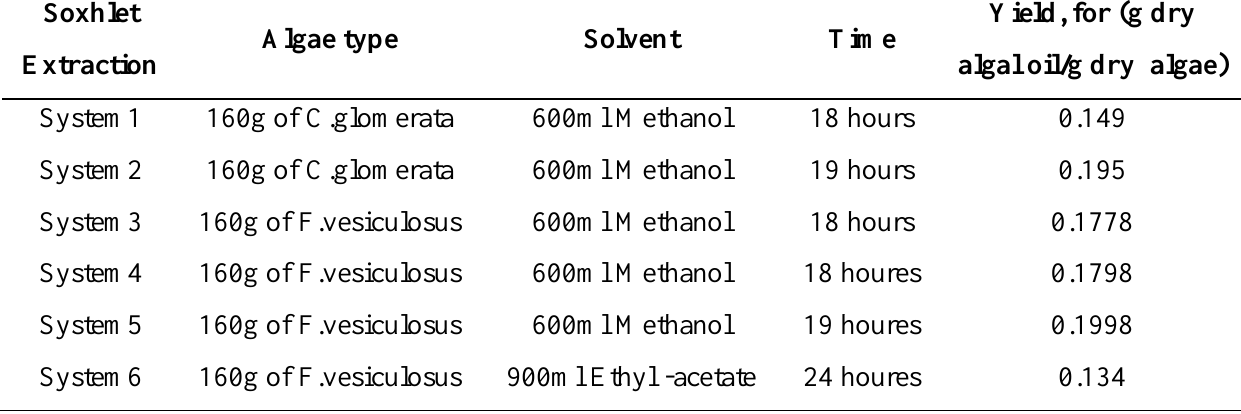
Table 1. Solvent volumes and algae used in each extraction